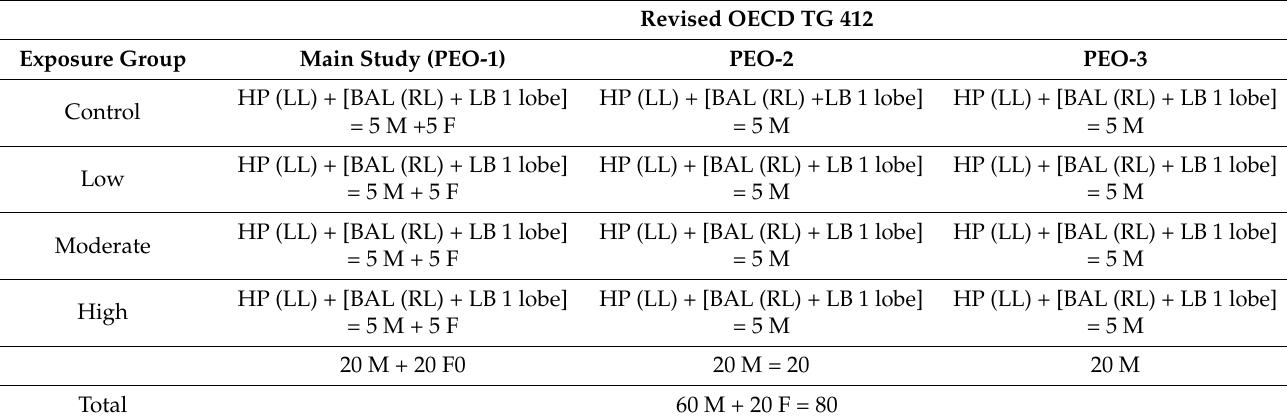
Table 4. Study design for TG 412 considering animal welfare.